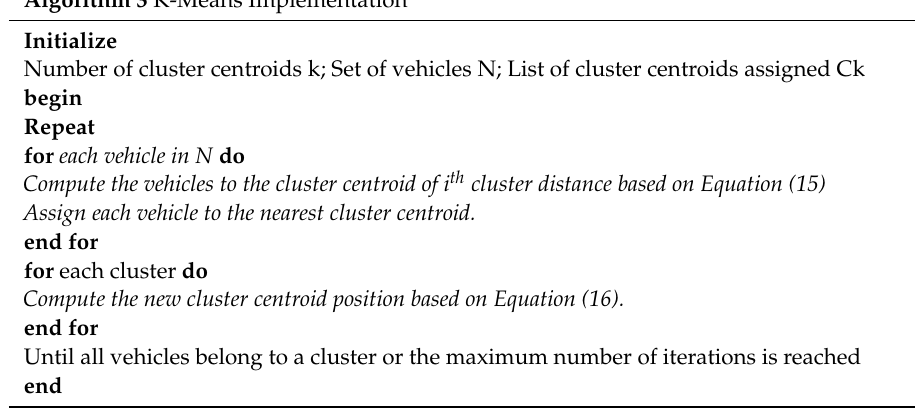
Algorithm 3 K-Means